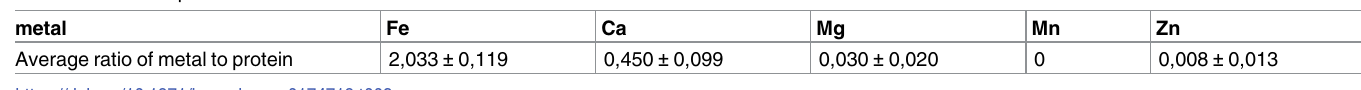
Table 2. Metals copurifying with ms-SpoIIE cyt . Metals associatedwith lyophilized ms-SpoIIE cyt were analyzedby ICP-OES. The mean and standarddevi- ation from two independent determinations are shown. metal Average ratio of metal to